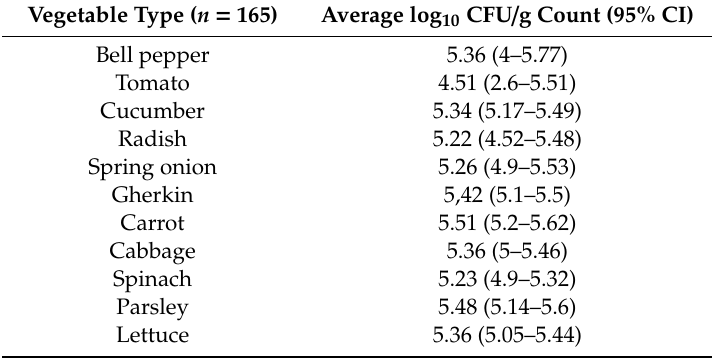
Table 2. Average number of Enterobacteriaceae colony-forming unit (CFU) count according to vegetable